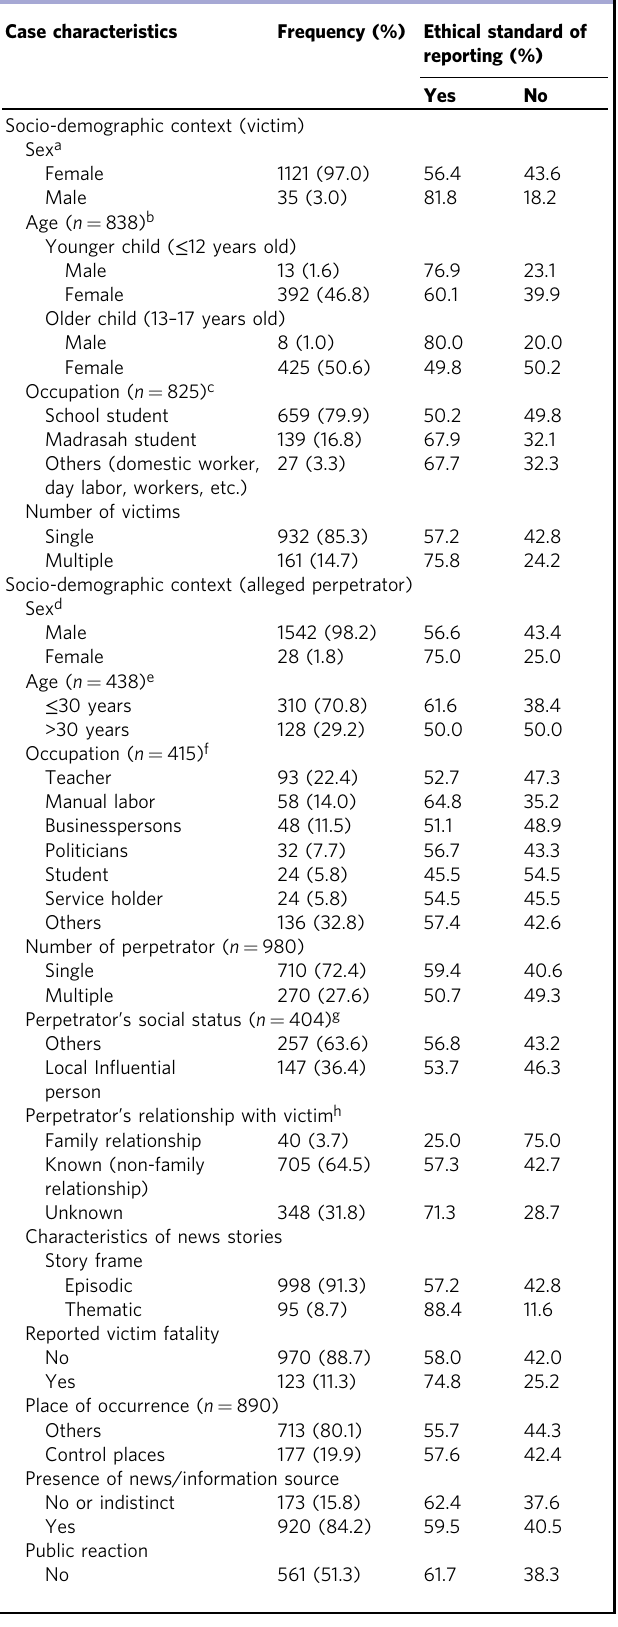
Table 1 Characteristics of CSA cases reported in daily newspapers of Bangladesh, 2017 ( N =